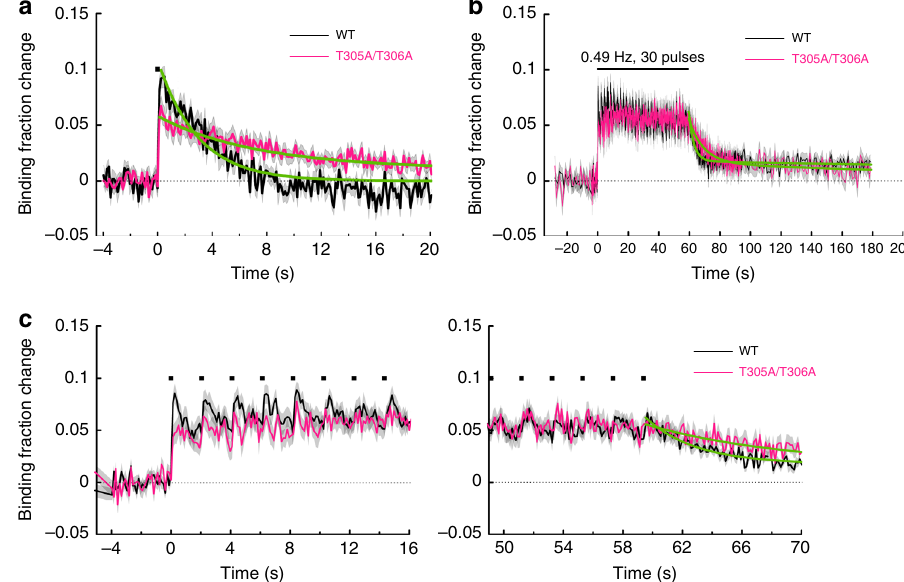
Fig. 5 Association of CaMKII α T305A/T306A -CaM during sLTP induction. a Averaged change in CaMKII α T305A/T306A -CaM association in a stimulated spine (magenta; n = 34 spines/6 neurons) in response to a single glutamate uncaging pulse (black square). The green curve on CaMKII α T305A/T306A is obtained by curve fi tting of an exponential function: B ( t ) = B 0 exp( – t / τ ). The dissociation time constant is obtained as τ = 7.5 ± 1.1 s. Inset is a expanded view. The data and fi tted curve for CaMKII α WT are from (Fig. 3c) for the comparison. b Averaged change in CaMKII α T305A/T306A -CaM association ( n = 27 spines/ 8 neurons) during glutamate uncaging at 0.49 Hz. The green curve indicates the decay of binding fraction change obtained by curve fi tting of a double- exponential function: B ( t ) = B 0 [ P fast · exp( – t / τ fast ) + P slow · exp( – t / τ slow )]. The time constants are obtained as τ fast = 9.3 ± 1.8 s ( P fast = 71%) and τ slow = 249 ± 229 s ( P slow = 29%). The data and fi tted curve for CaMKII α WT are from (Fig. 2d) for the comparison. c Expanded view of the initial phase (left) and the late phase (right) in